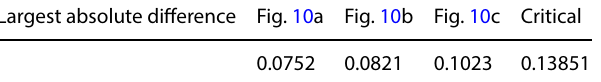
Table 8 Kolmogorov–Smirnov test results for the Monte Carlo sim- ulations of Fig. 13 Largest absolute difference Fig. 10a Fig. 10b Fig. 10c